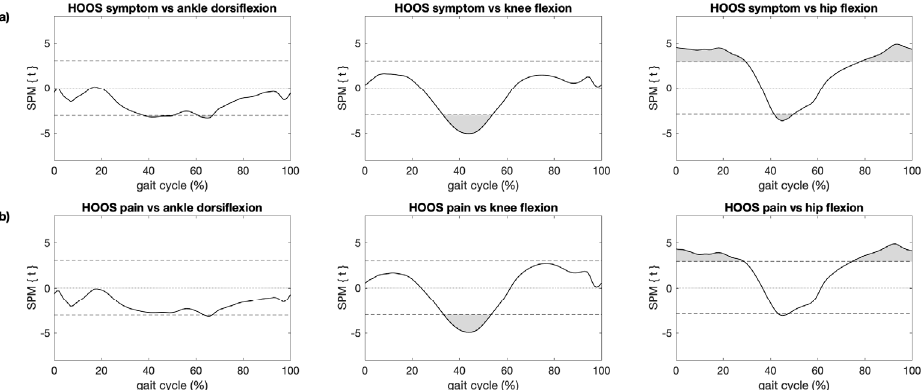
Figure 6. Association between HOOS subscores and kinematic trajectories. Results of statistical para- metric mapping with regression analysis (SPM{t}) are shown for ( a ) the HOOS subscore symptoms and ( b ) the HOOS subscore pain and the ankle (left), knee (center) and hip (right) of the affected/left leg where grey areas illustrate regions with statistically significant relationships between HOOS subscores and kinematics ( p <